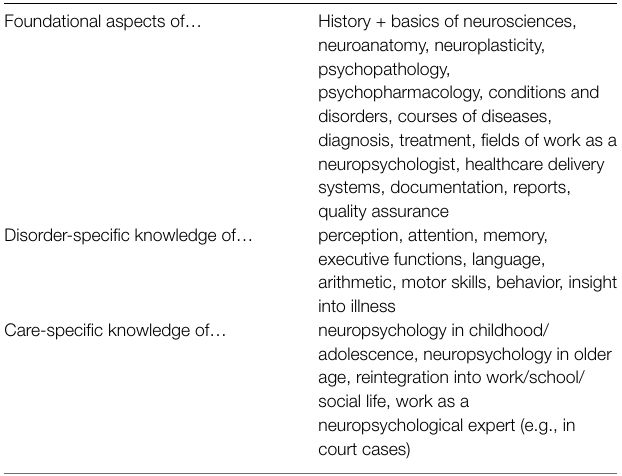
TABLE 1 | The German clinical neuropsychology training curriculum.